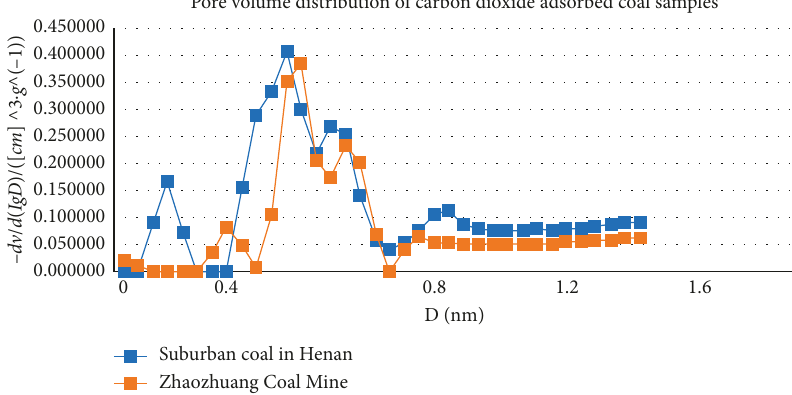
Figure 7: The pore volume distribution curve of carbon dioxide adsorption coal sample.